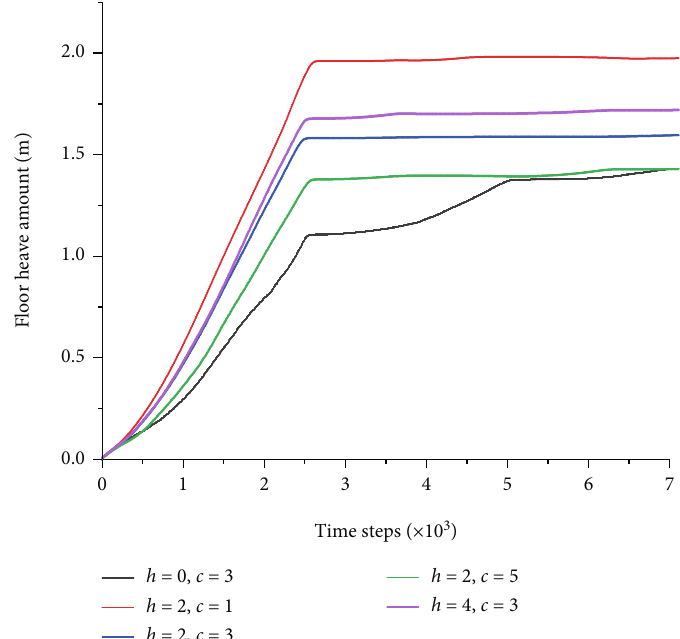
Figure 12: Floor heave amount.